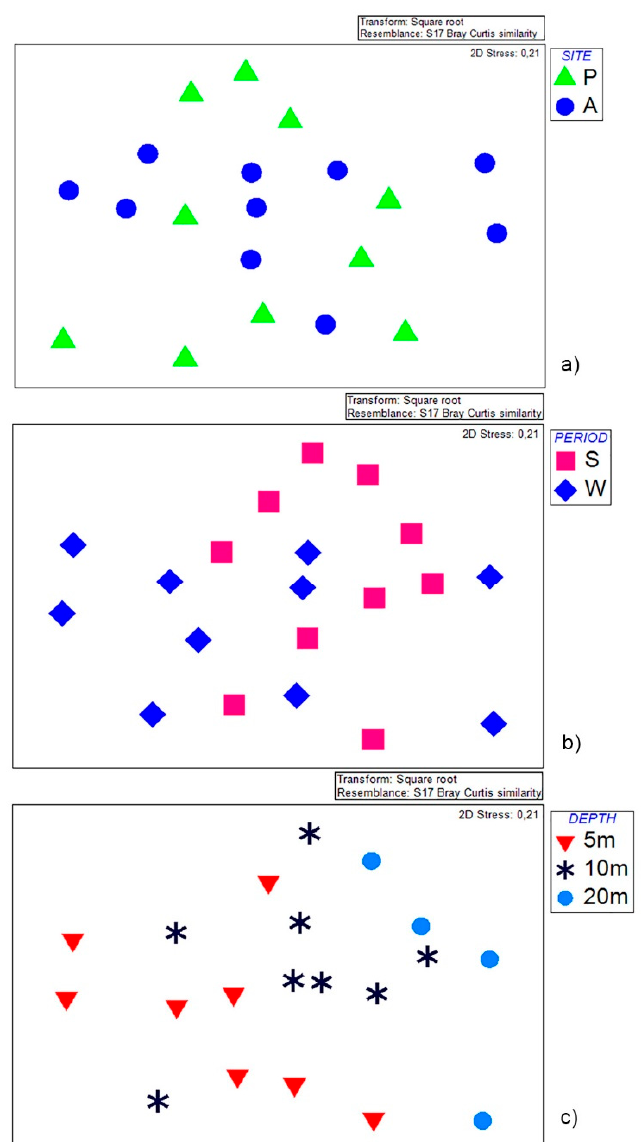
Figure 2. nMDS plot on the relative copepod densities according to ( a ) site ( b ) season and ( c ) depth.